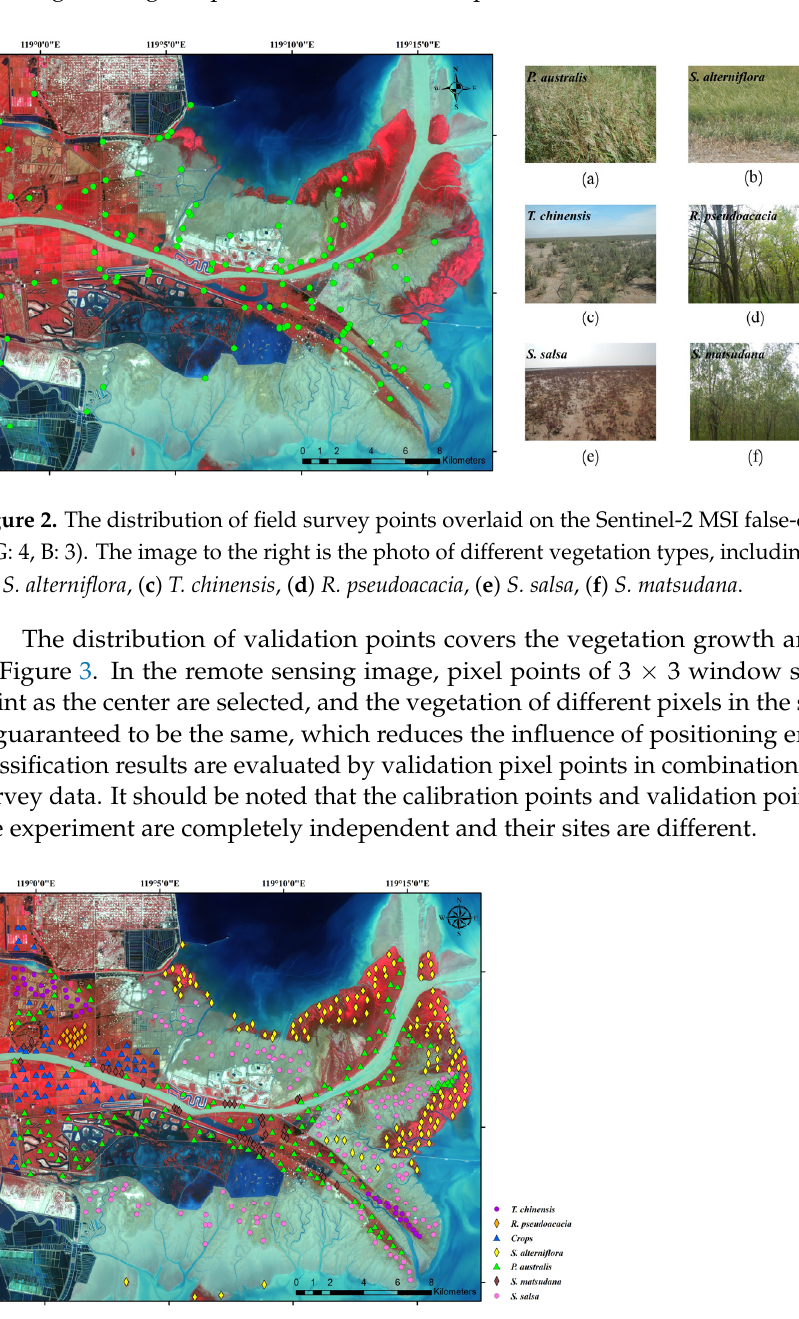
Figure 3. The distribution of verification